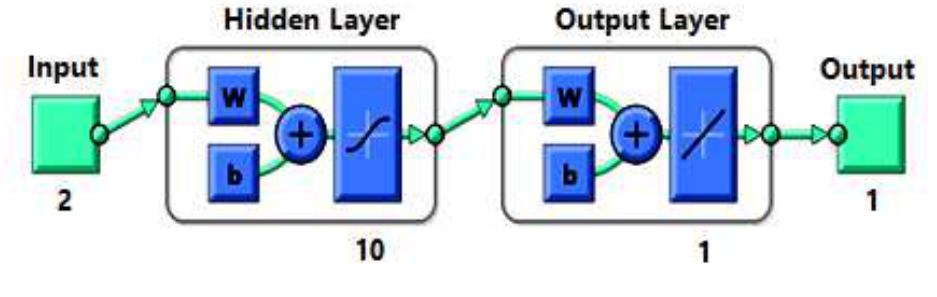
Figure 22. AN-N Model.